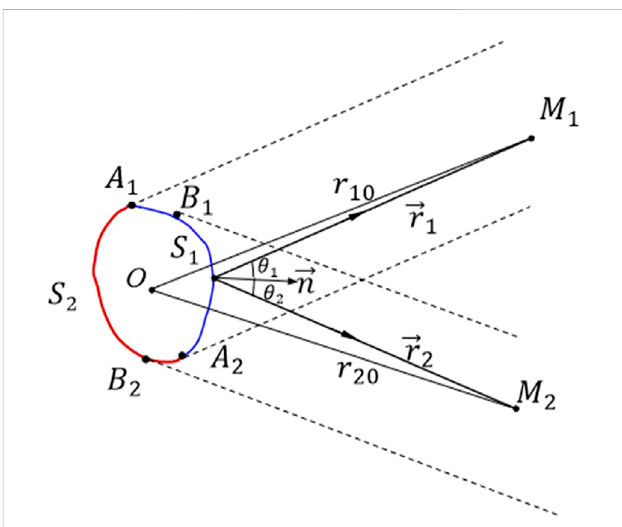
FIGURE 1 Schematic diagram of the derivation of the physical acoustic method with the source and receiver